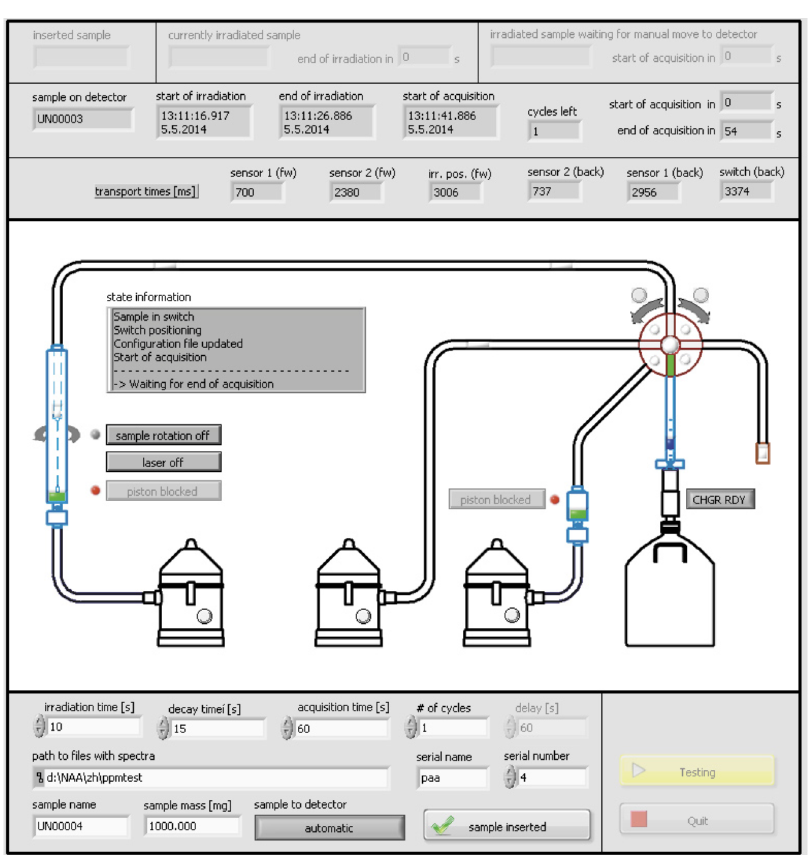
Figure 3. Graphical user interface for the control of the pneumatic tube delivery system showing its schematic design (from left to right: irradiation terminal, 3 vacuum cleaners, 4-way routing head, detector with a Dewar cooling). Reproduced from [17] with permission from Springer Nature.